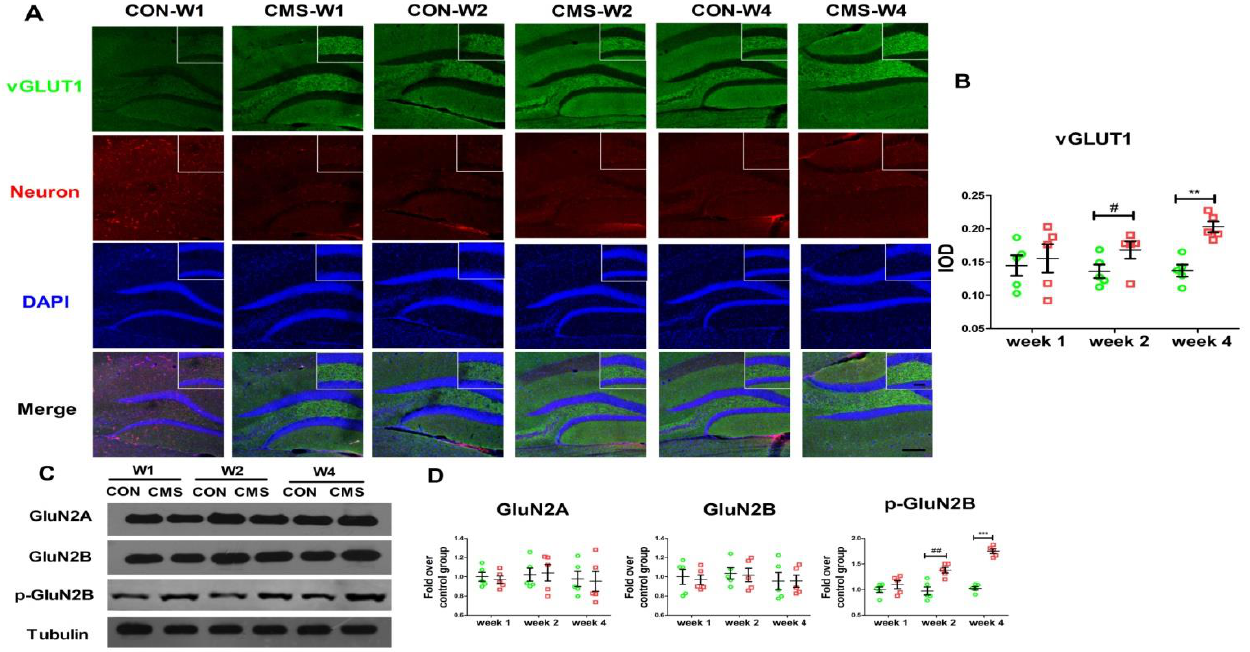
Figure 3. The limited activation of the Glutamatergic neurons in the hippocampus of mice by a moderate duration of stress. ( A , B ) Immunofluorescence of VGluT1 in the DG of hippocampus in the 3-month-old mice. VGluT1 (Green), Neuron (Red), DAPI (Blue), and the merge pictures (×10 magnification) were presented on the left side. Quantification of the result (IOD) was shown on the downside. The numbers of mice were N = 5 per group and the numbers of sections used N = 5 per mouse. ( C , D ) The levels of the postsynaptic receptors GluN2A, GluN2B, and p-GluN2B were detected with Western blot in the hippocampus, respectively. N = 5 per group, each sample was repeated three times, expressed as mean ± SEM. ** p < 0.01, *** p < 0.001, 4-week CMS vs. 4-week CON; # p < 0.05, ## p < 0.01, 2-week CMS vs. 2-week CON. Scale bars are 200 um.